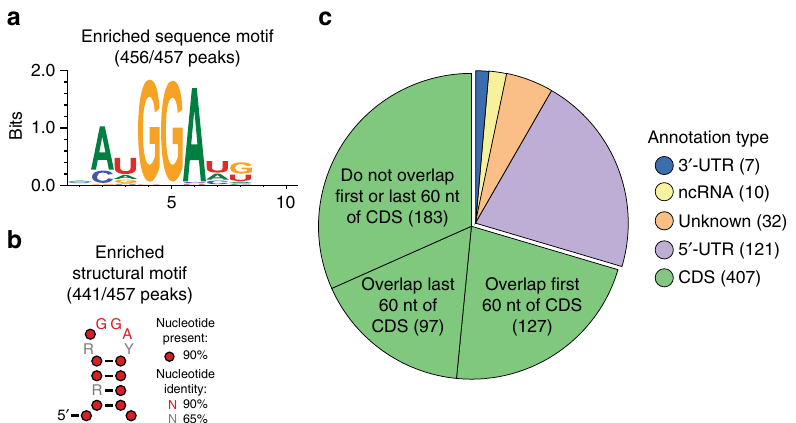
Fig. 2 CLIP-seq analysis reveals global patterns of CsrA binding targets. a Enriched sequence motif identi fi ed in CsrA CLIP-seq peaks with Zagros 70 . b Enriched predicted structural motif identi fi ed in CLIP-seq peaks with CMFinder 71 where R = G or A, Y = C or U. c Localization of CsrA CLIP-seq peaks relative to known or predicted coding sequences (CDS), ncRNAs 77 , transcriptional start sites 4, 78 , and transcriptional terminators 4 . Each peak may